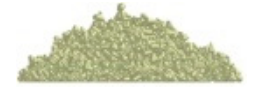
Figure 12. Measured AoR 38.65° Figure 13. Simulation result 38.54°